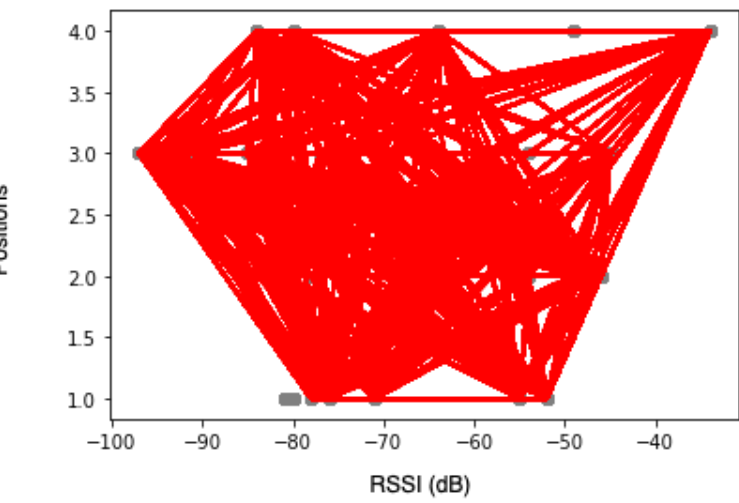
Figure 10. Model point